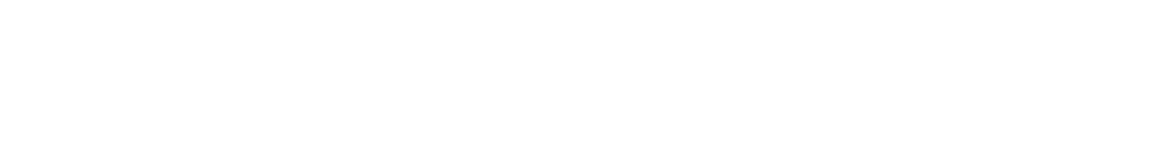
Frontiers in Cell and Developmental Biology |